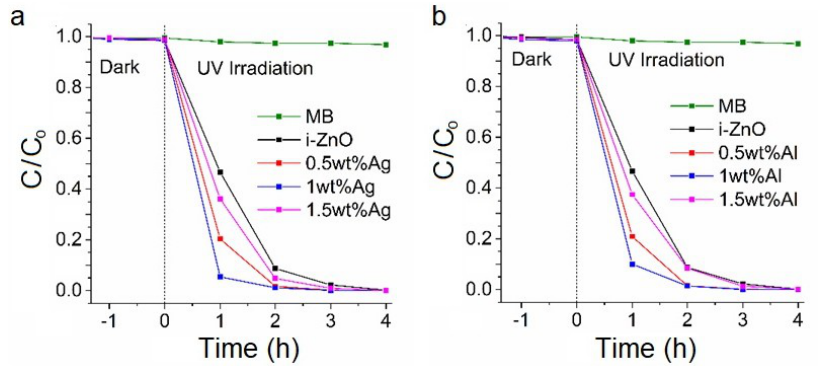
Figure 7. Methylene blue concentration after photocatalytic degradation for different times in presence of ( a ) Ag-doped ZnO films and ( b ) Al-doped ZnO films.